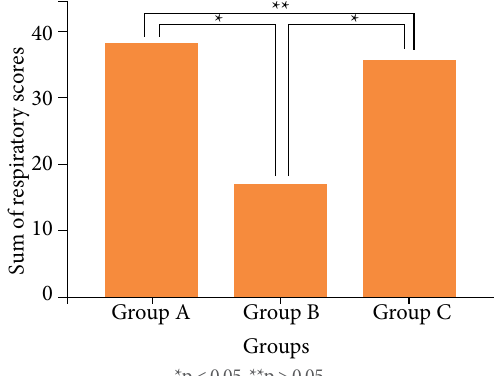
Figure 5 - Sum of respiratory scores for each group. Group B had the lowest respiratory score.